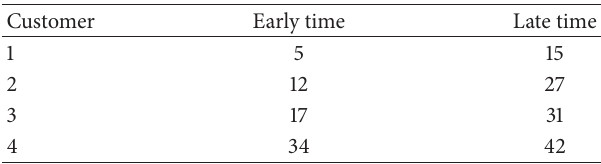
Table 1: Customers’ time windows for the sample problem.